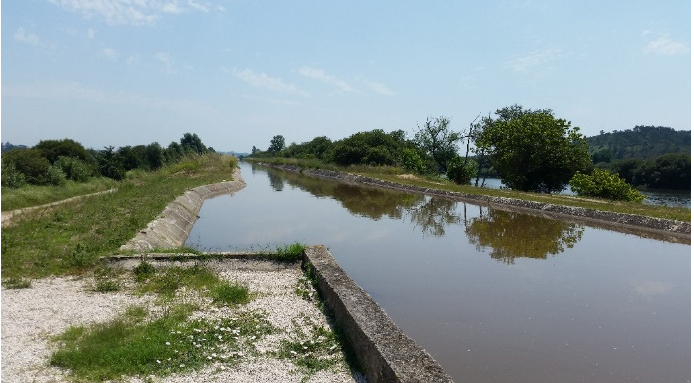
Figure 8. Main channel in the Low Mondego (photograph taken in the right margin of Mondego river, close to the Foja river outlet).